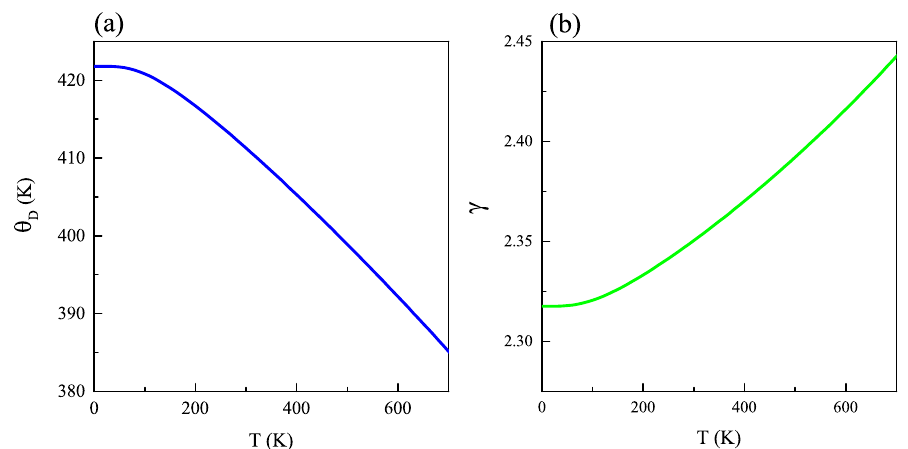
Figure 3. ( a ) Debye temperature and ( b ) Grüneisen parameter as functions of temperature in bulk kesterite Cu 2 ZnGeS 4 .